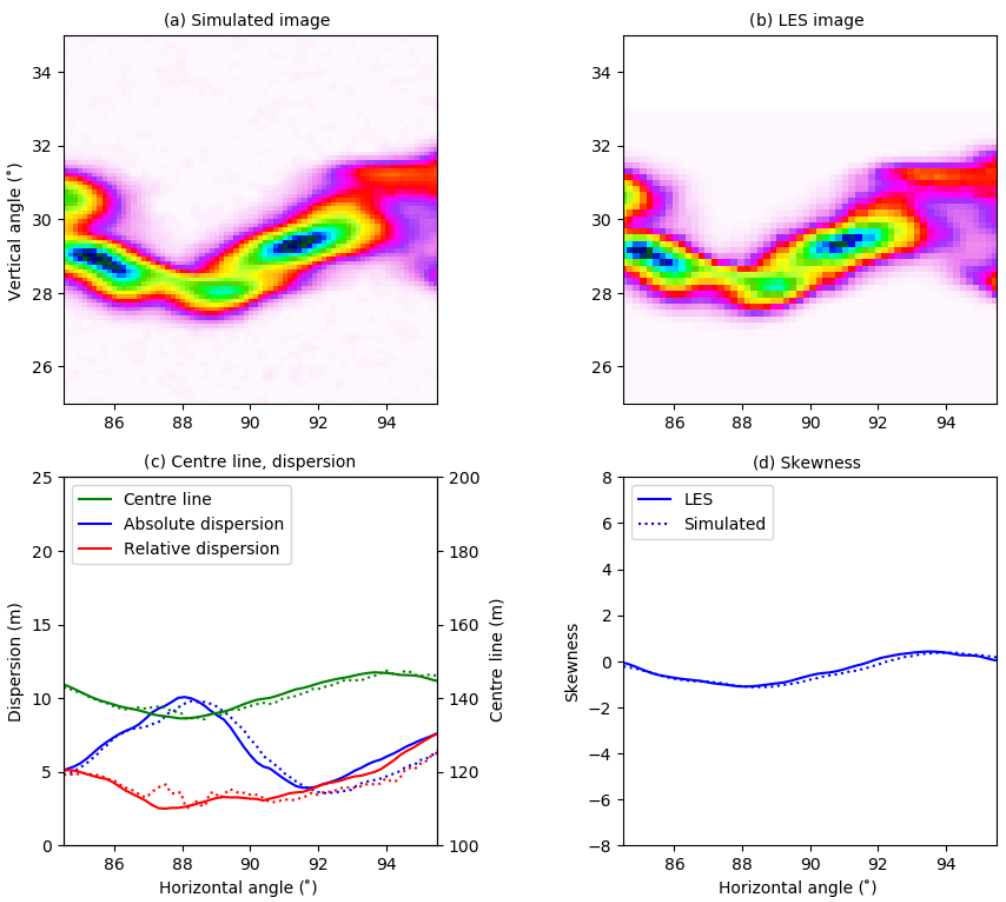
Figure 5. Similar to Fig. 4 but for camera B and time step